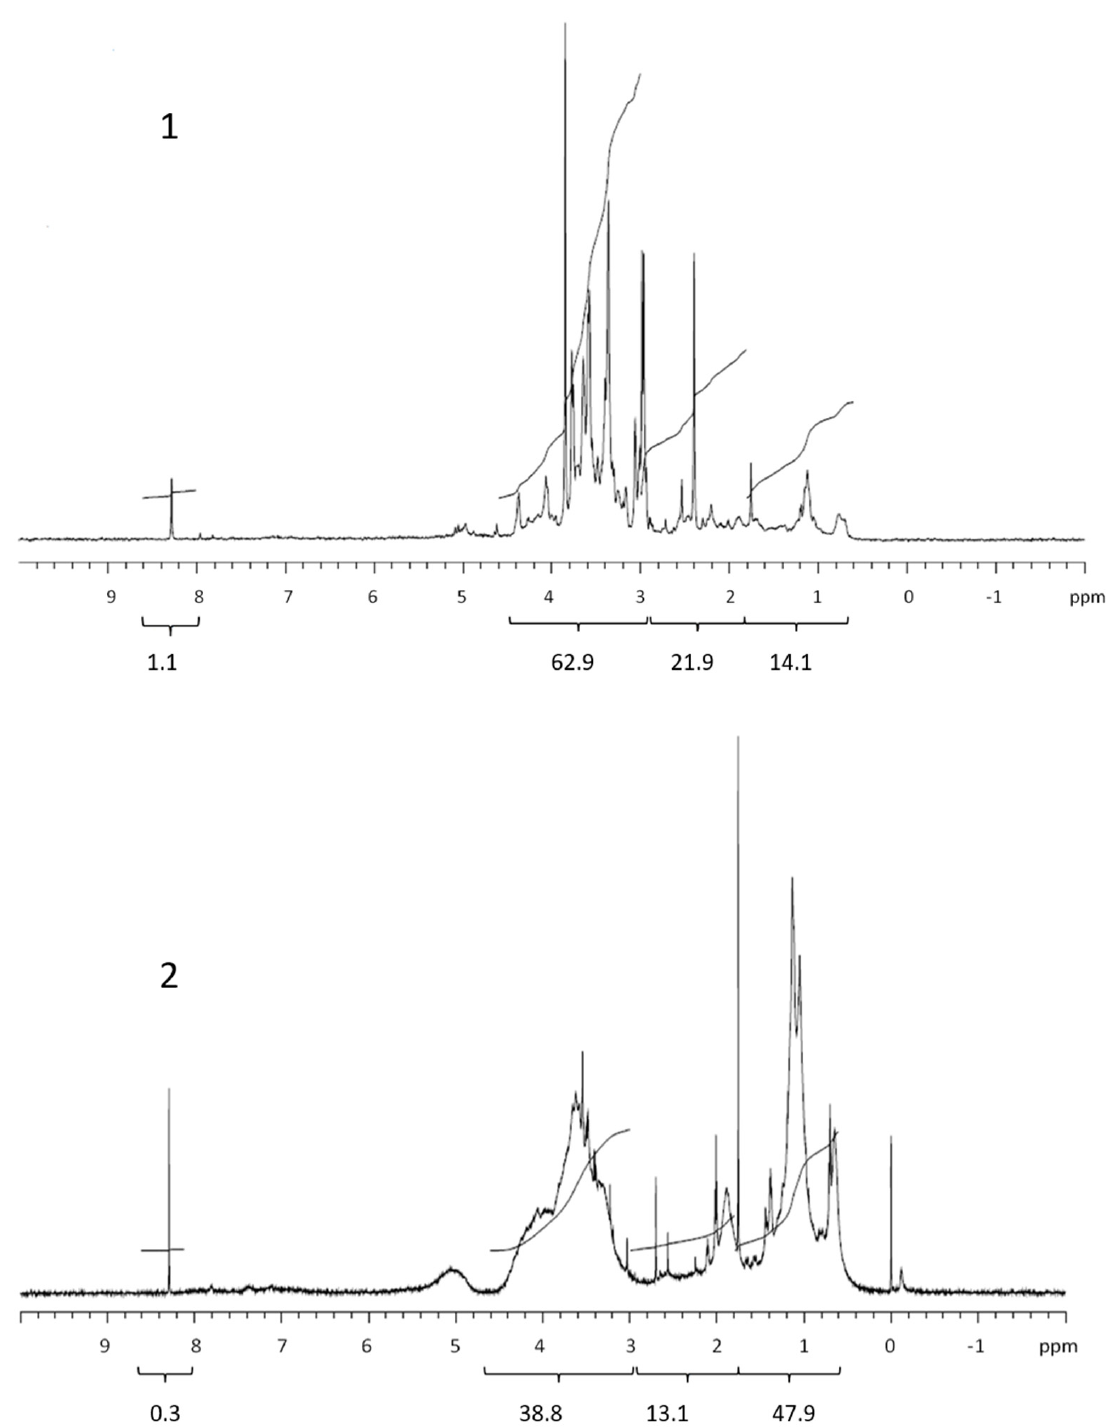
Figure 4. Comparison between 1 H NMR spectra of marine COM from July 2012 ( 1 ) and COM isolated from exudate of Chaetoceros socialis ( 2 ). Values below brackets are integrated